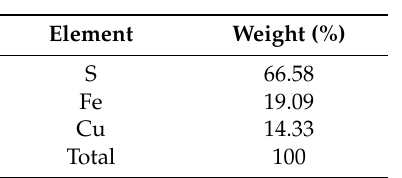
Figure 3. Chalcopyrite in the leach residues of column 1. Table 7. Chalcopyrite in the leached residues of column 1.